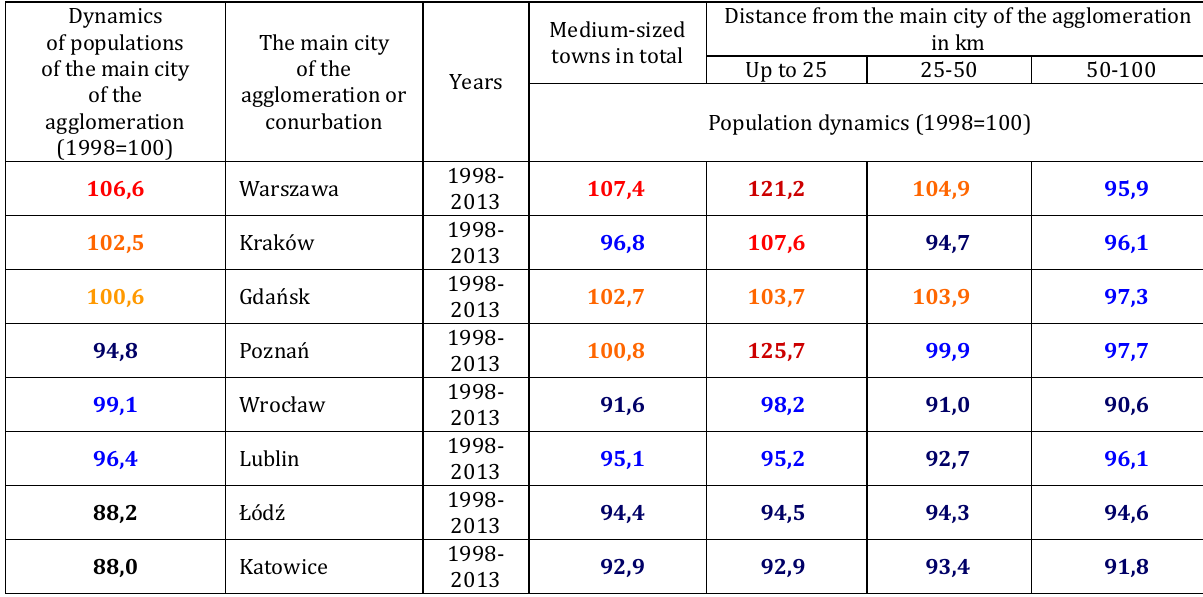
Table 3. Dynamics of the populations of the medium-sized towns in the years 1998-2013 by distance zones (source: the author's study based on Local Data Bank of Central Statistical Office)